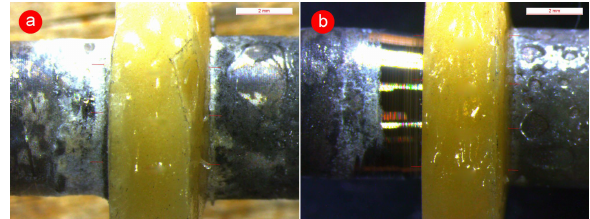
Figure 2: Edge between metal and ceramic material (a) before and (b) after grinding process